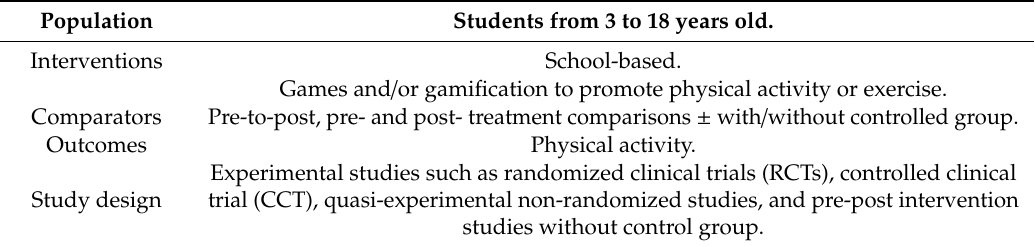
Table 1. PICOS tool